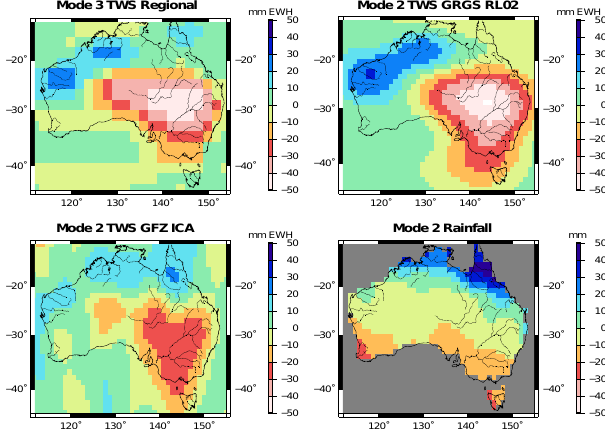
Fig. 8. Spatial components of PCA 3rd orthogonal mode of regional solutions and 2nd mode of GRGS, ICA 400km-filtered solutions and rainfall